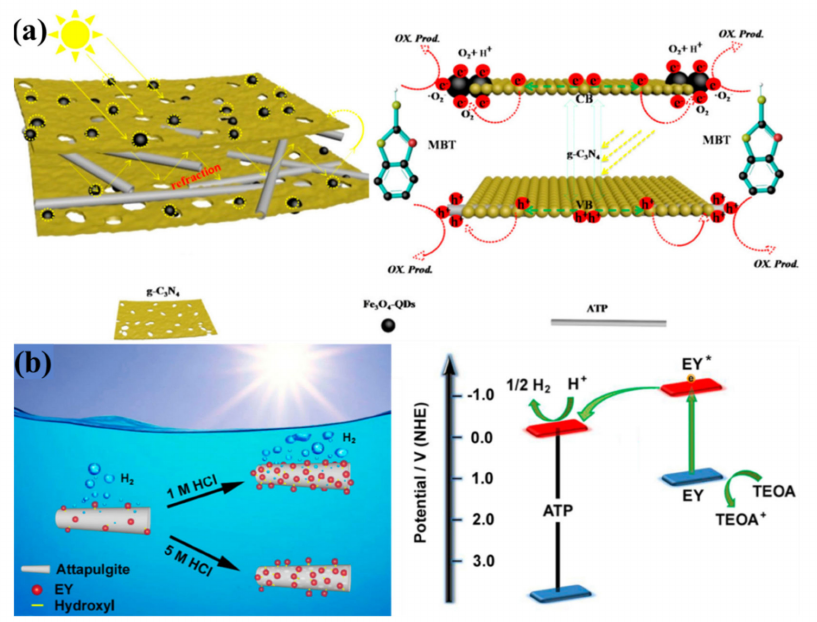
Figure 3. ( a ) Diagram of Fe 3 O 4 -QDs@g-C 3 N 4 /ATP and the mechanism for degradation of 2-mercaptobenzothiazole (MBT) under visible light irradiation; ( b ) schematic illustration of charge separation and transfer over EY-ATP photocatalysts and interface modified strategy of ATP we proposed under visible light ( λ ≥ 420 nm). Adapted with permission from Ref. [75]. Copyright 2017, American Chemical Society; Adapted with permission from Ref. [81]. Copyright 2016, American Chemical